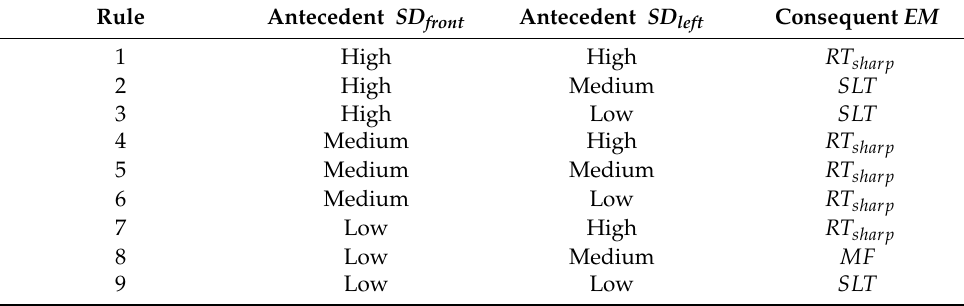
Table 4. Neutrosophic logic-based indoor detection: a set of basic